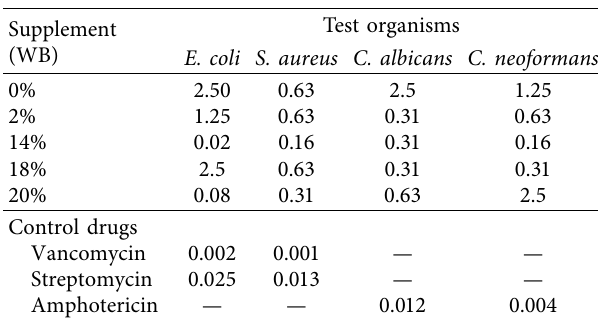
Table 2: Minimum Inhibitory concentration (MIC) (mg/ml) of methanol extract of P — ostreatus mushroom grown on bagasse substrates supplemented with varying levels of wheat bran.